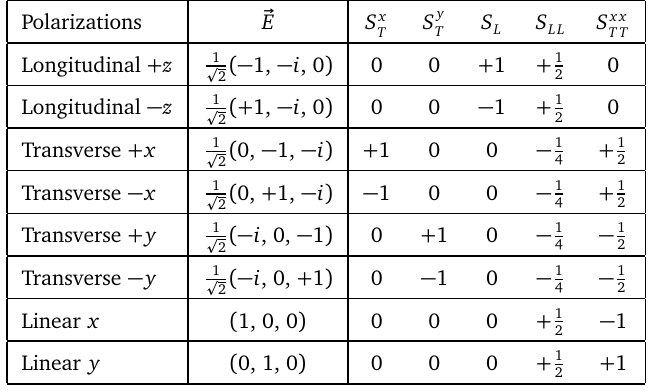
= S x = S y = 0). The TT LT LT TT